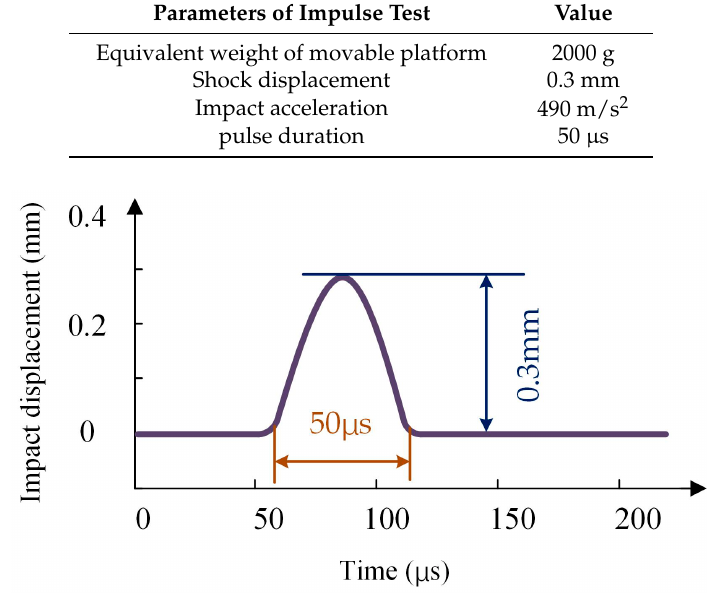
Figure 11. Time-domain impact profile.